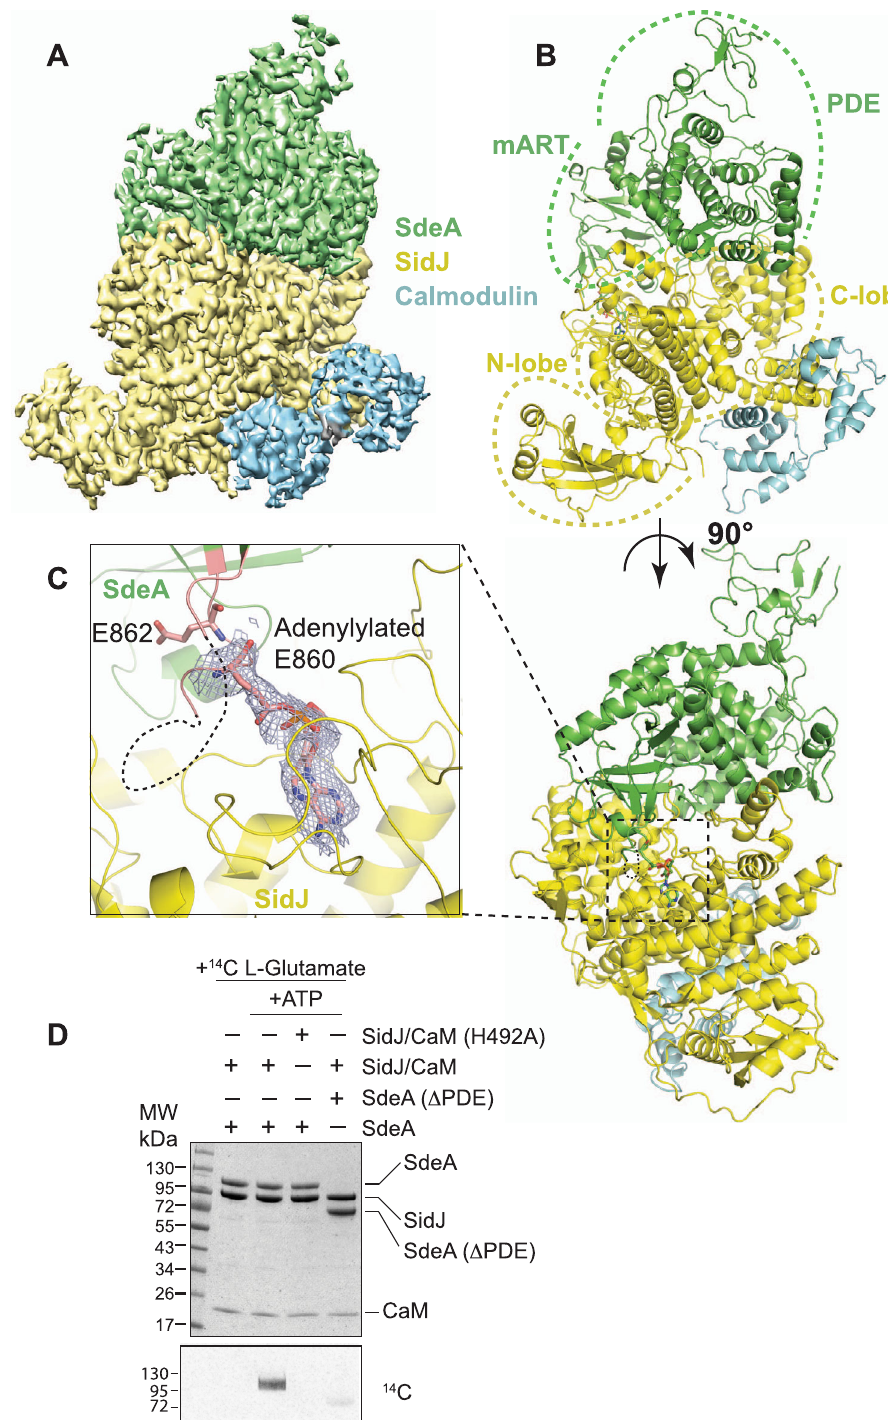
Fig. 2 Adenylylated SdeA E860 binds to the migrated pocket of SidJ. A Cryo-EM map of SidJ E565A (Yellow), Calmodulin (Teal), and SdeA (Green). B Overall structure of the reaction intermediate SidJ E565A/CaM/SdeA heterotrimer. Both N- and C-lobe of SidJ (Yellow), as well as mART and PDE lobes of SdeA (Green) are highlighted, with Calmodulin (Teal) bound to the C-terminus of SidJ. C Closer view of the migrated nucleotide-binding pocket of SidJ (Yellow), and adenylylated SdeA E860 (Stick representation, Green) inserted. The cryo-EM density of E860 of SdeA and AMP is shown in the mesh. SdeA catalytic loop is colored in salmon. E862, another glutamylation target of SidJ is also shown. D Incorporation of [14 C]-Glu into SdeA with and without its PDE domain present. Reaction components were separated by SDS-PAGE and either visualized by Coomassie stain (Top) or autoradiography (Bottom).